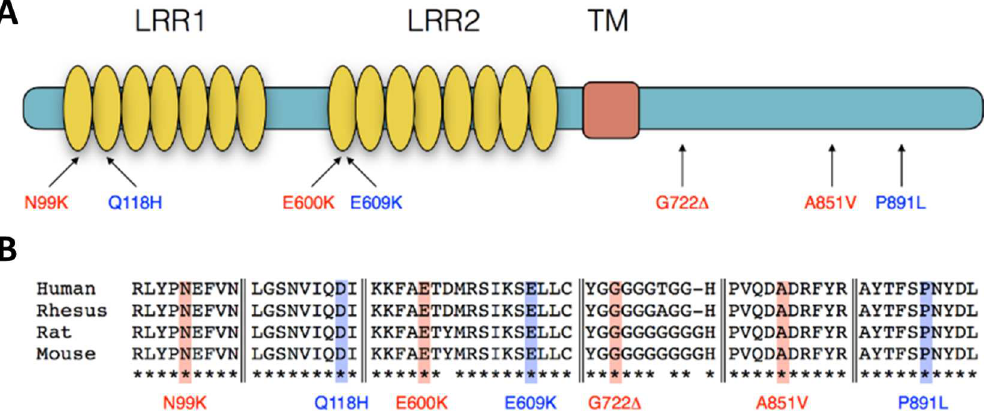
Fig 1. Structure of Slitrk5 and location of rarenon-synonymous mutations. (A) Schematic representation of the Slitrk5proteinwith extracellularLeucineRichRepeat(LRR)domainsandtransmembrane(TM) domainmarked. Mutationsidentified in OCD subjectsare labeledin red andpseudo-matchedmutations from 1000GenomeDatabase subjectsare labeledin blue.(B) SLITRK5mutationsplacedin theirprimarysequencecontext. All mutationsalter absolutelyconservedpeptidecontextsdenotedby